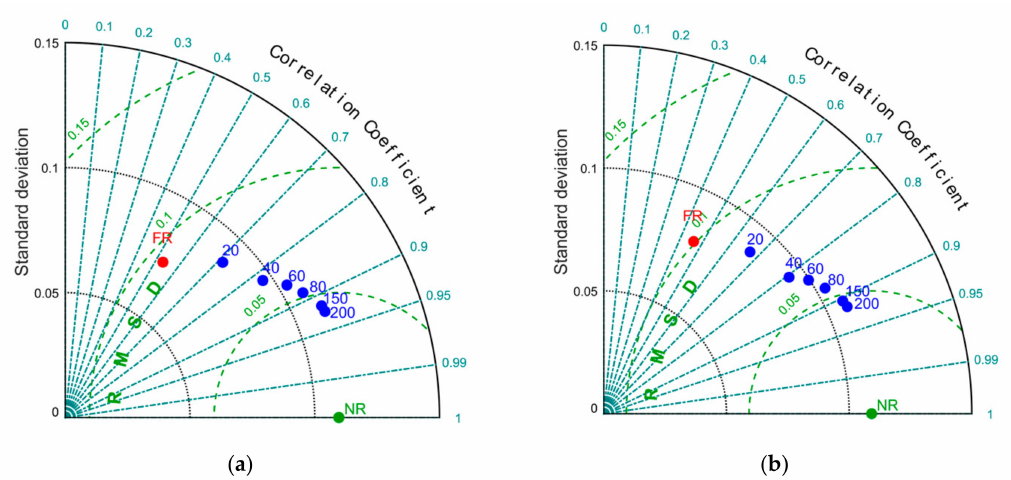
Figure 8. Representation of the average point representing a di ff erent ensemble of ( a ) the analyses obtained from datasets of velocity measures characterized by a di ff erent number of observation points randomly positioned: 20, 40, 60, 80, 150, and 200; ( b ) the subsequent